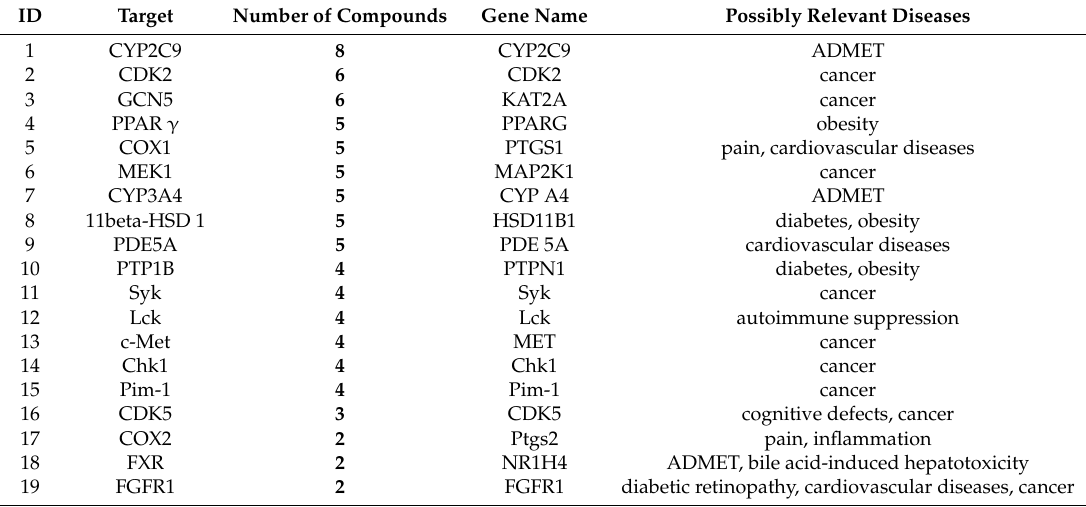
Table 2. Predicted target information of GTs.